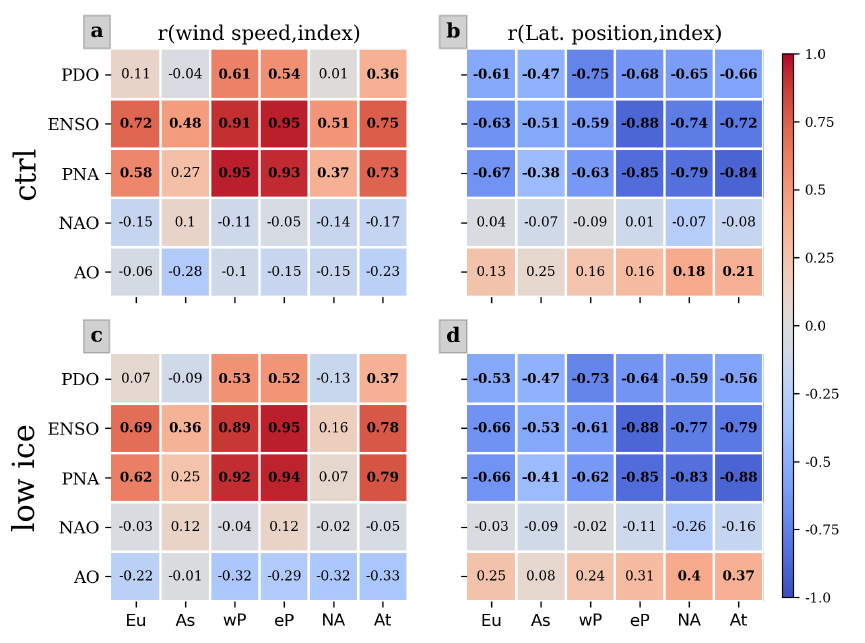
Figure 9. Pearson correlation between winter STJ wind speed and latitudinal position from the SSTreal case and ocean-atmosphere climate oscillation indices. ( a ) STJ wind speed from the control ensemble, ( c ) STJ wind speed from the experimental ensemble, ( b ) position from the control ensemble and ( d ) position from the experimental ensemble. Bold numbers indicate statistical significance at the 95% confidence